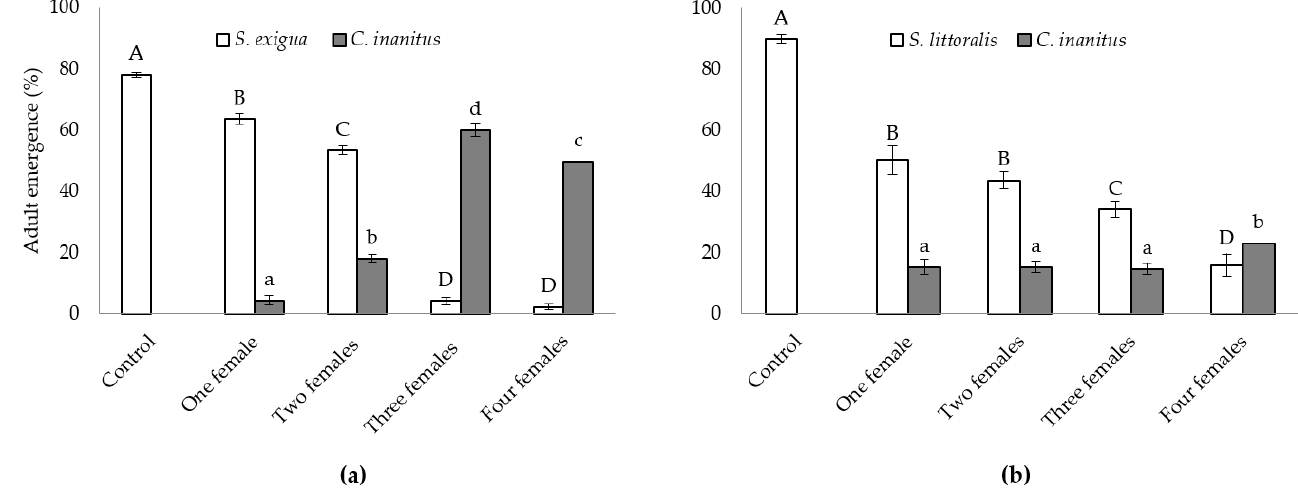
Figure 1. Chelonus inanitus parasitism success inside the greenhouse, depending on the number of females parasitizing simultaneously. Data (mean ± SEM) are percentages of noctuid and parasitoid adults emerged from 60 host eggs offered to the parasitoid. In white, host emergence; in grey, parasitoid emergence. Letters stand for significant differences among treatments ( p < 0.05). ( a ) Spodoptera exigua host; ( b ) Spodoptera littoralis host.